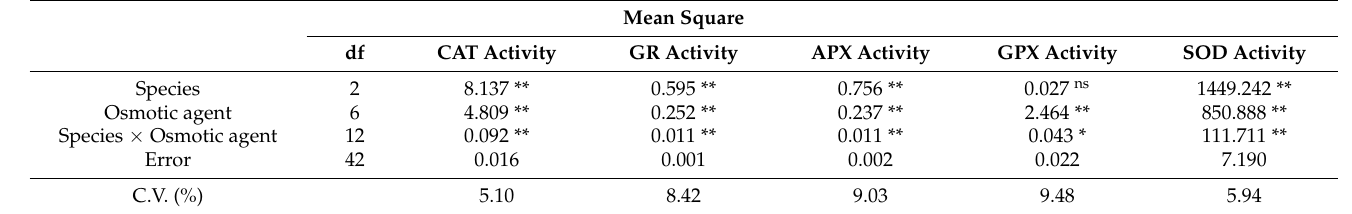
Table 4. The ANOVA analysis of the effects of PEG and mannitol on enzyme activity in Cucurbita sp. genotypes under in vitro